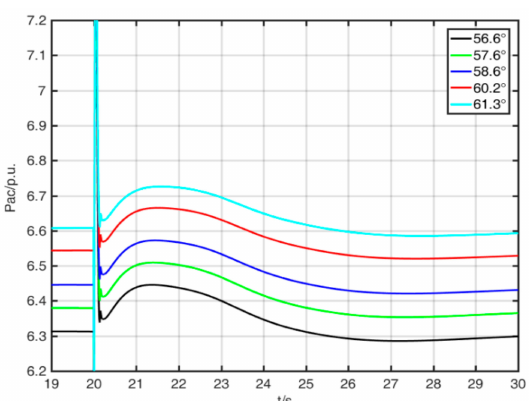
Figure 4. Transmission power of the DC line.